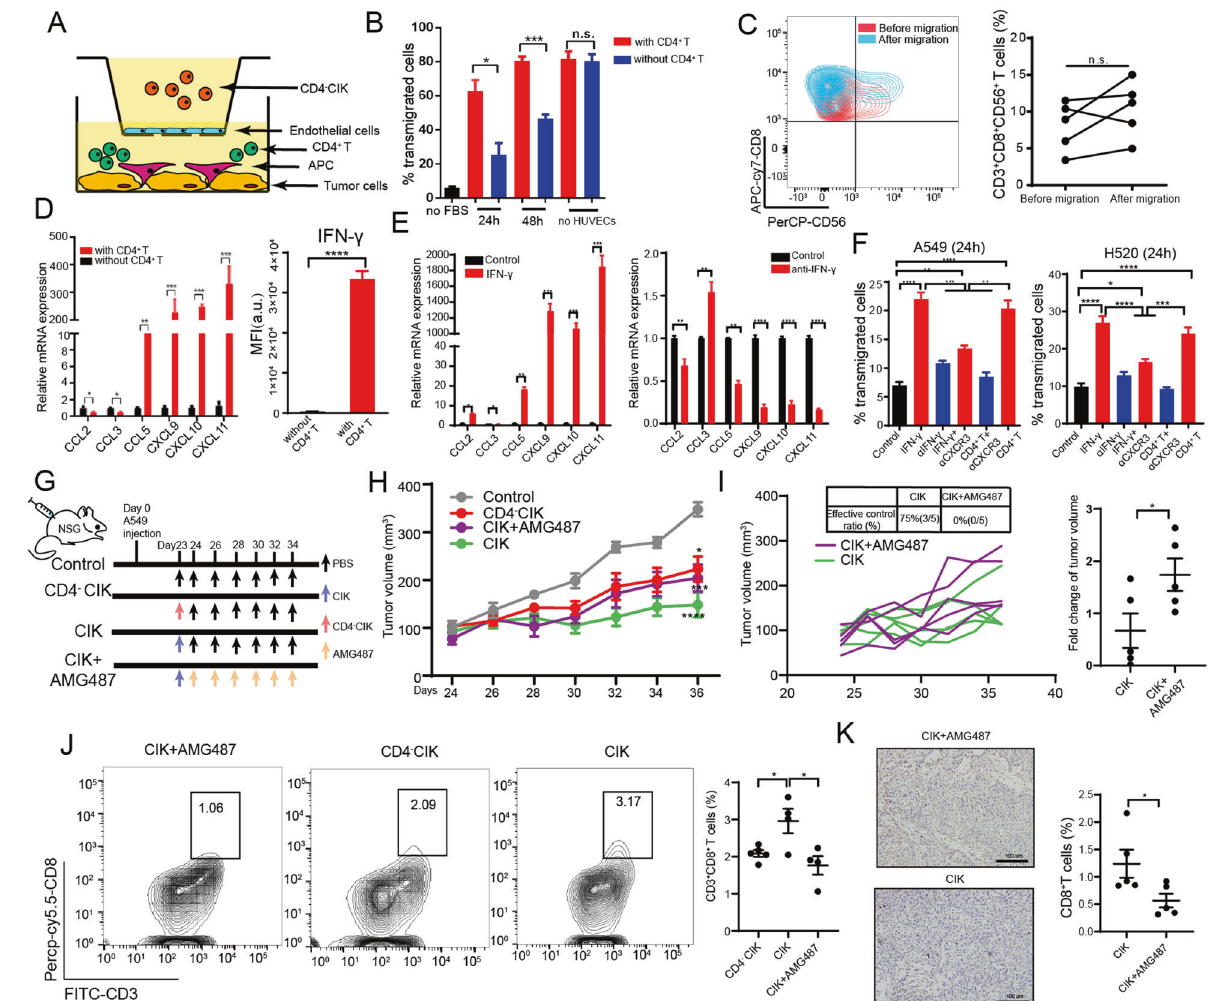
Fig. 2 CD4 + T cells improved the migration of CD4 − CIK cells through IFN- γ /CXCL9,10,11/CXCR3. A Illustration of chemotaxis assay of CD4 − CIK cells toward supernatants derived from mixed tumor co-cultures. B Quanti fi cation of CD4 − CIK cell migration in the tumor- conditioned medium in the presence or absence of CD4 + T cells. C Flow cytometric quanti fi cation of CD4 − CIK migration in the tumor- conditioned medium before and after transmigration. D Quanti fi cation of chemokine-related mRNA expression in tumor cells and macrophages (left); fl ow cytometric analysis of IFN- γ expression in supernatants from tumor-conditioned medium (right). E Quanti fi cation of chemokine-related mRNA expression in tumor cells and macrophages in the presence of IFN- γ or anti-IFN- γ . F Quanti fi cation of CD4 - CIK cell migration in tumor (A549 or H520)-conditioned medium in the presence of different neutralizing antibodies, IFN- γ or CD4 + T cells at 24 h. G Schematic diagram depicting the dosing schedule and timing for a subcutaneous transplantation tumor model. H , I Subcutaneous growth of tumor cells (A549) in each group of mice ( n = 5) treated with PBS, CD4 - CIK cells, CIK cells, and CIK + AMG487. J Flow cytometric examination of the number of CD3 + CD8 + T cells in fi ltration in tumor. K Speci fi c imaging of immunohistochemistry from CIK + AMG487 and CIK groups, scale bars: 100 µm. Error bars indicate SEM, * P < 0.05, ** P < 0.01, *** P < 0.001, and **** P < 0.0001 (one-way ANOVA or Student's t